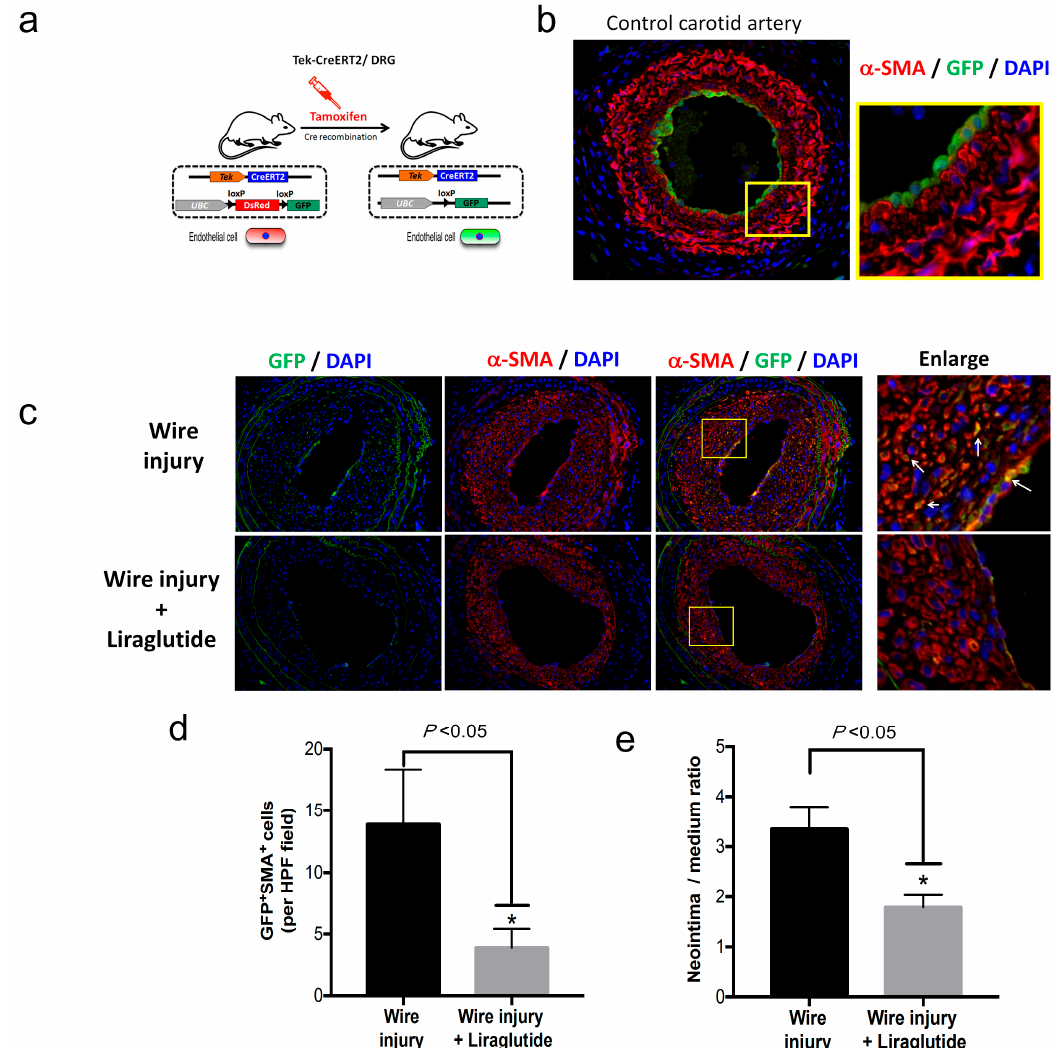
Figure 2. Endothelia-derived cells contribute to neointima formation through EndMT. ( a ) Schematic representation of the induction of endothelial-specific GFP labelling after tamoxifen injection in TekCreERT2 / DRG mice. ( b ) Representative images of immunofluorescence staining for the protein expression of GFP (green) and α -SMA (red) in the common carotid artery. Nuclei were counterstained with 4 ′ ,6-diamidino-2-phenylindole·2HCl (DAPI) (blue). The enlarged field (yellow square) represents the GFP expression in the endothelial layer of the carotid artery. ( c ) STZ-induced diabetic TekCreERT2 / DRG mice were subjected to a wire-induced injury or a wire injury plus liraglutide treatment ( n = 4 in each group). The common carotid arteries were collected on day 28. Representative images show the immunofluorescence staining for GFP (green), α -SMA (red), and nuclei (blue) in wire-injured common carotid arteries. The enlarged field (yellow square) represents the co-localization of GFP expression in α -SMA-positive cells (white arrowheads) in the neointima. ( d ) Quantification of the number of GFP + SMA + cells in the neointima area between groups. ( e ) Quantification of the neointima to media ratio between groups. * P < 0.05, analyzed by Student’s t -test. 3.3. Endothelium-Derived Cells Contribute to Neointima Formation Following Artery Injury through EndMT in Diabetic